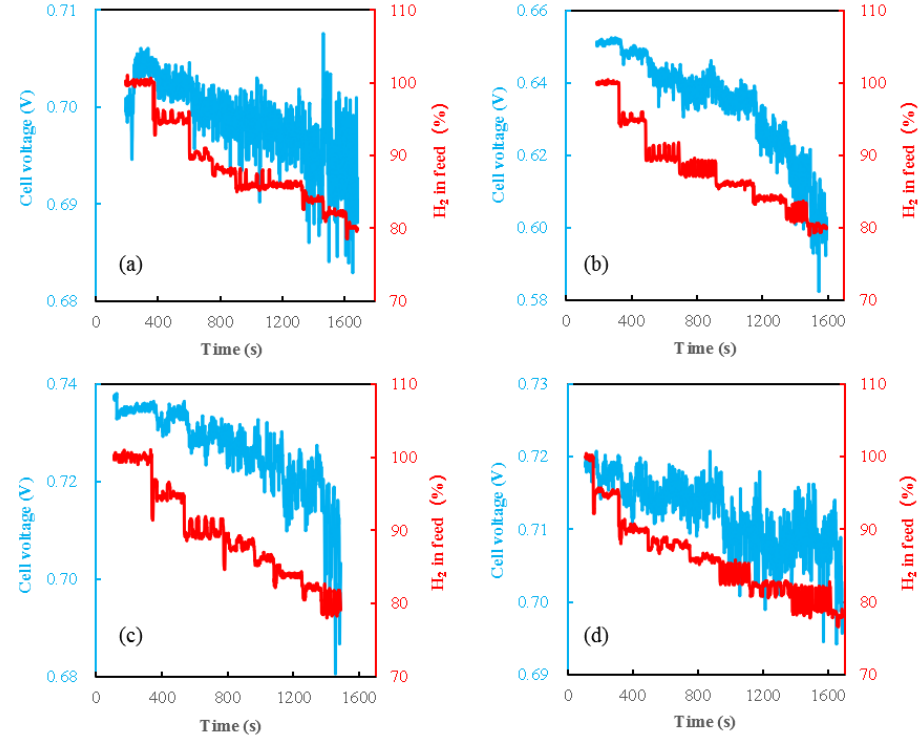
Figure 9. Test results of cell 4 at different current densities: ( a ) 0.2 A · cm − 2 ; ( b ) 0.6 A · cm − 2 ; ( c ) 1.0